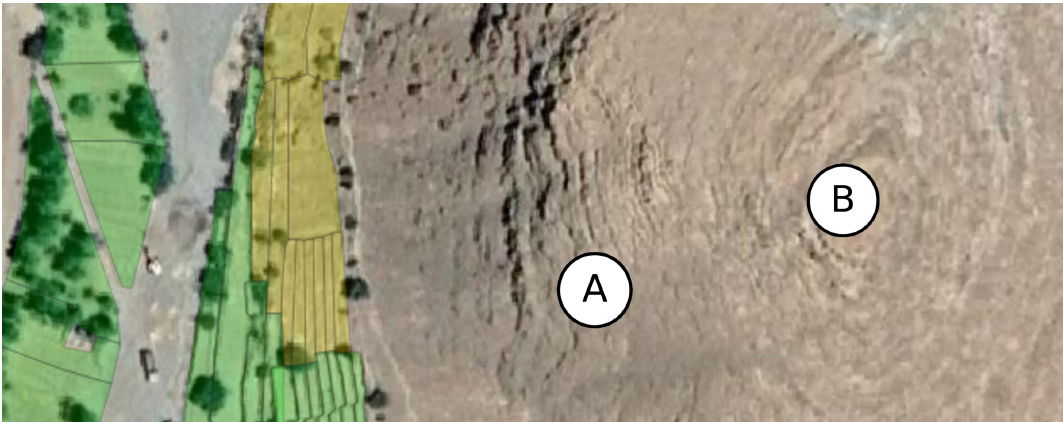
Figure 9. Terraces detected in GIS software by hand with satellite imagery from Google as